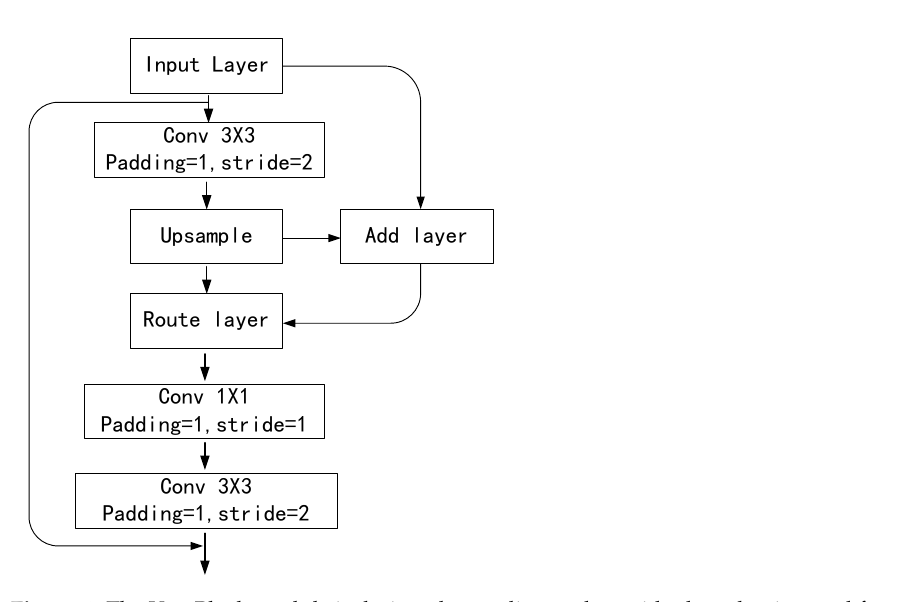
Figure 4. The VaryBlock module is designed according to the residual mechanism and feature fusion method of add and